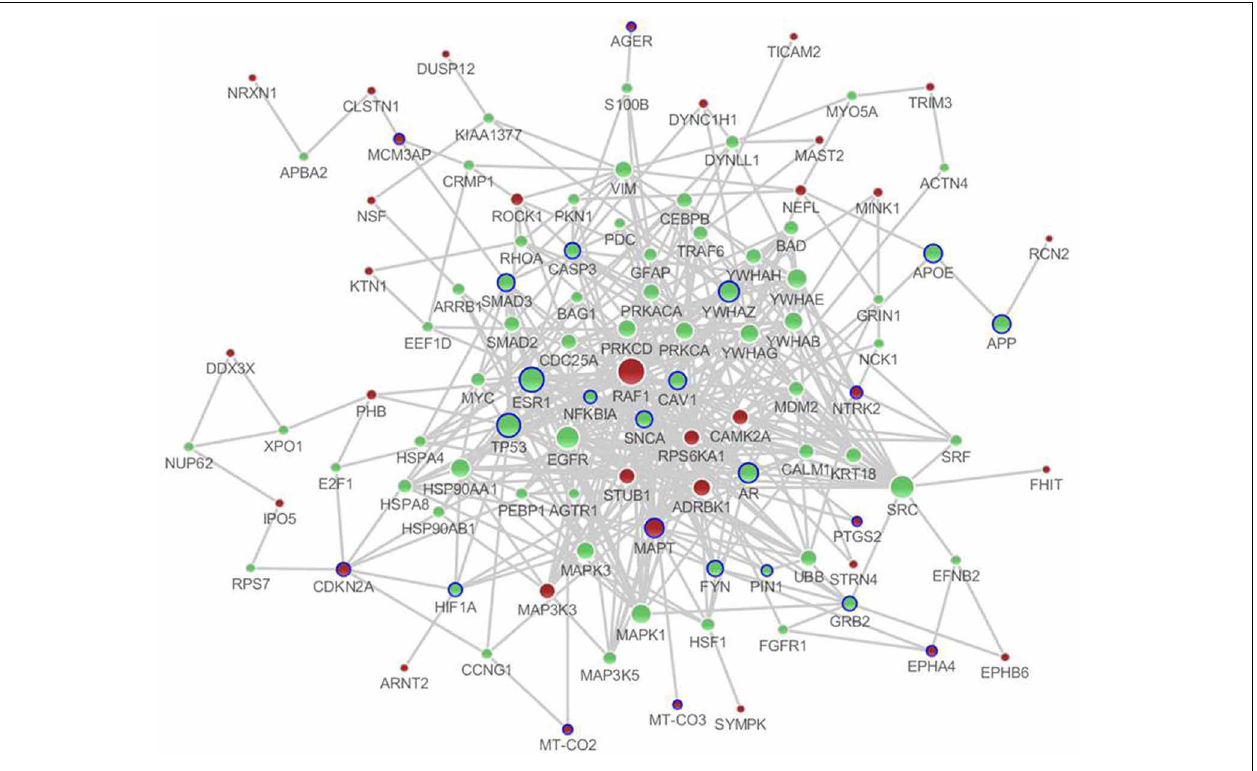
FIGURE 2 | The distinct genetic sub-network of hippocampus and cerebral cortex in SAMP8 mice based on PPI network. Red nodes represent differential expressed genes in SAMP8 mice, green nodes are